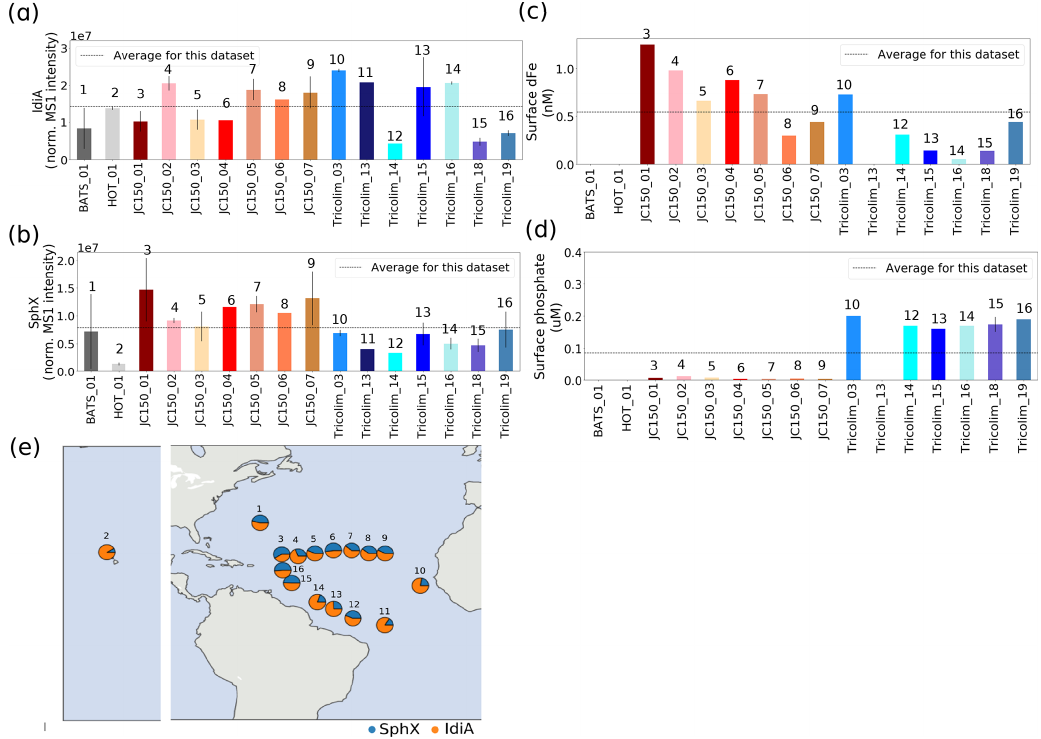
Figure 3. Relative abundance of iron stress protein IdiA (a) and phosphate stress protein SphX (b) . IdiA and SphX were among the most abundant proteins in the entire dataset. Error bars are 1 standard deviation from the mean. Dashed lines represent average values across the dataset. Protein abundances were normalized such that the total MS1 peak area across the entire proteome was the same for each sample. (c, d) Concentrations of dissolved Fe and dissolved phosphate nutrients. (e) Relative abundance of IdiA (orange) and SphX (blue) overlaid on the sampling